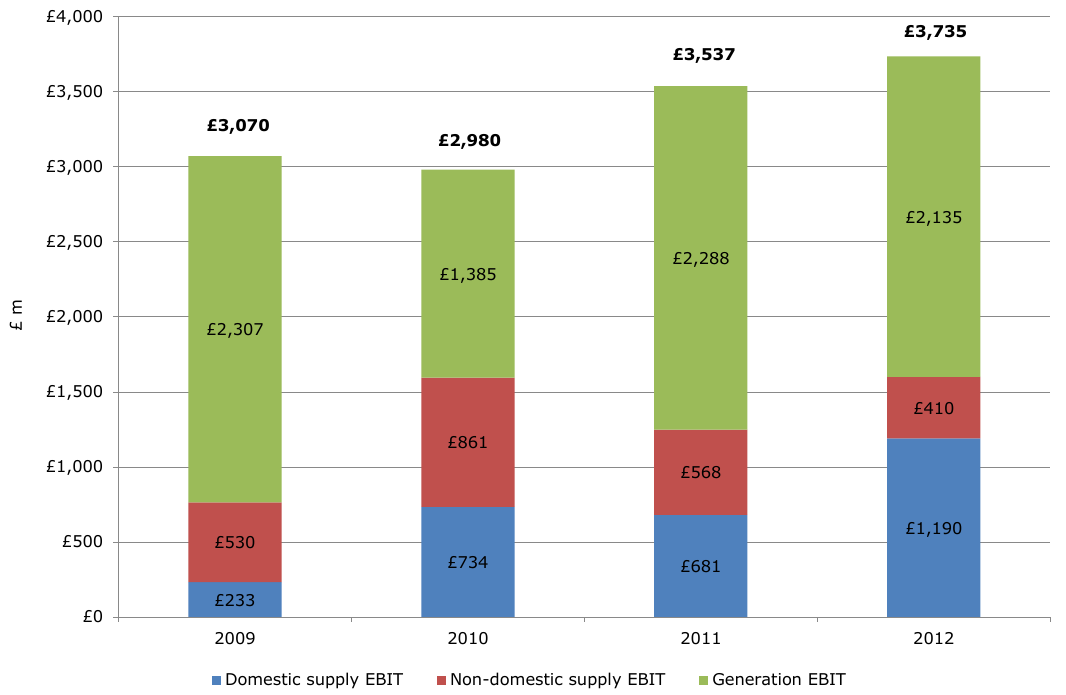
Figure 44: six largest suppliers combined generation and supply EBIT (FY09-FY12), consolidated EBIT